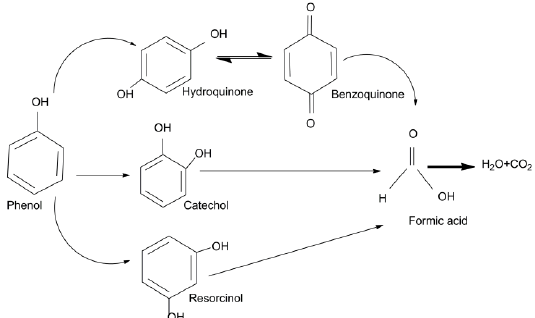
Figure 6. Photocatalytic degradation pathways of phenol under visible light irradiation in the presence of ZnO nanorods with high surface defects as photocatalysts depicting the complete mineralization process of phenol where O–H bonds are broken and resulting in the formation of multiple channels starting with hydroquinone, catechol and resorcinol. Benzoquinone is reversible with hydroquinone. The aromatic ring is opened and results in the formation of aliphatic compounds, such as mineral acids, water and carbon dioxide.